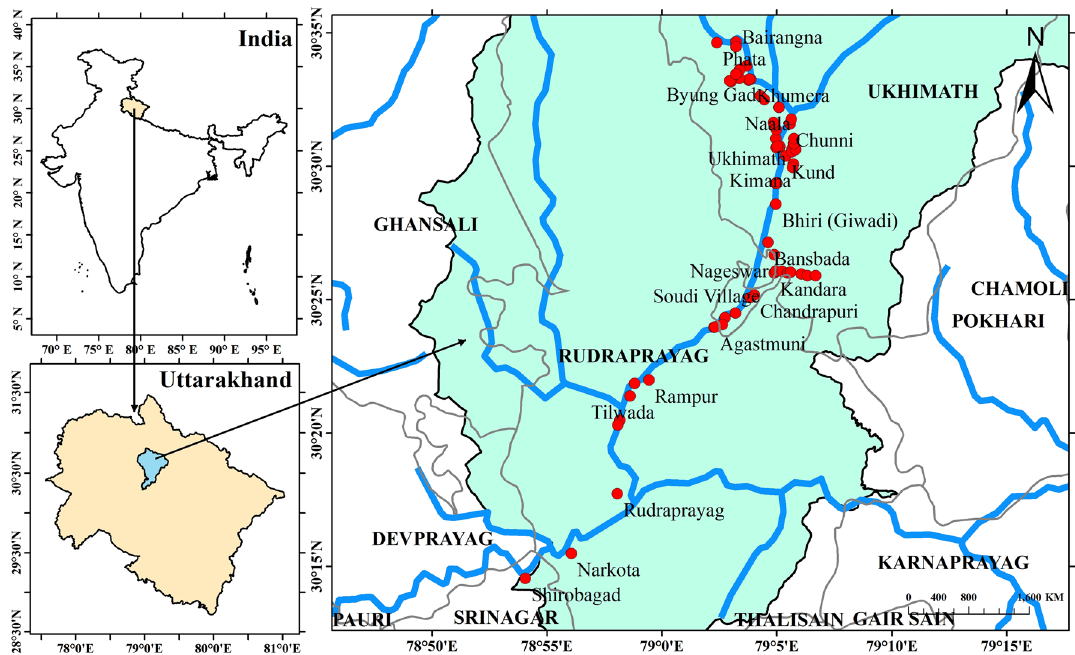
Figure 1. Location map (prepared with ArcGIS, version 10.7.1, URL: https:// www. esri. com/ en- us/ arcgis/ produ cts/ arcgis- deskt op/ resou rces) of the study area in the Himalayan region of Uttarakhand,